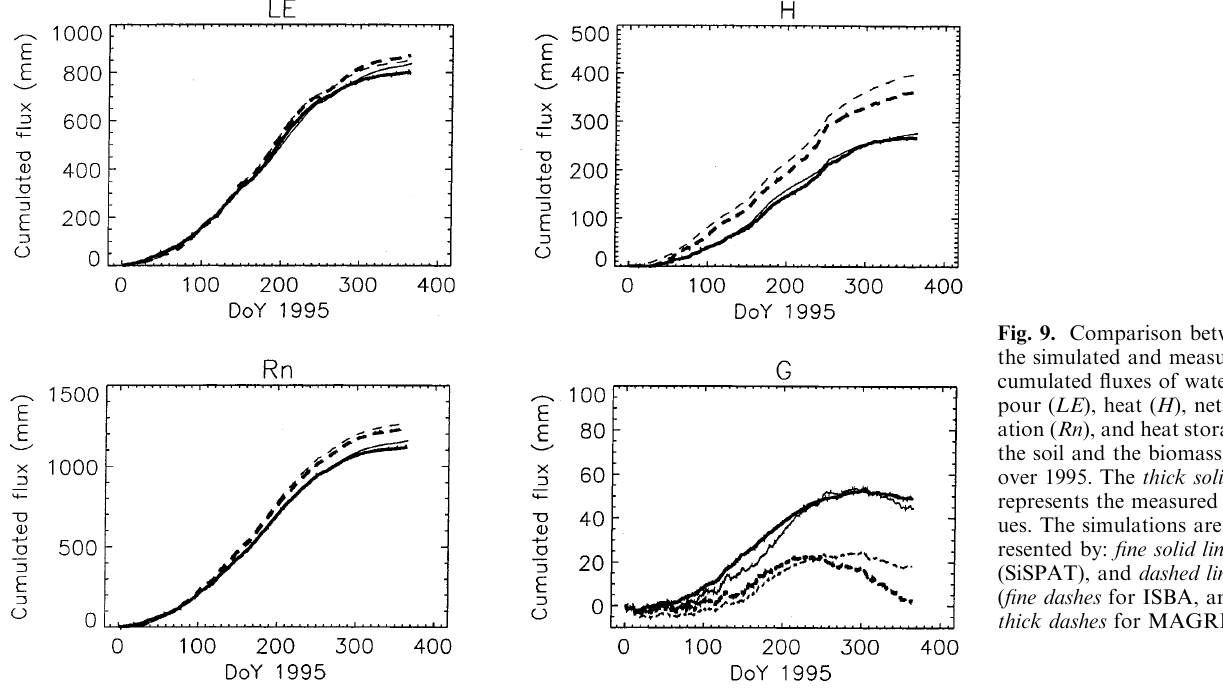
Fig. 9. Comparison between the simulated and measured cumulated fluxes of water va- pour ( LE ), heat ( H ), net radi- ation ( Rn ), and heat storage in the soil and the biomass ( G ) over 1995. The thick solid line represents the measured val- ues. The simulations are rep- resented by: fine solid line (SiSPAT), and dashed lines ( fine dashes for ISBA, and thick dashes for MAGRET)